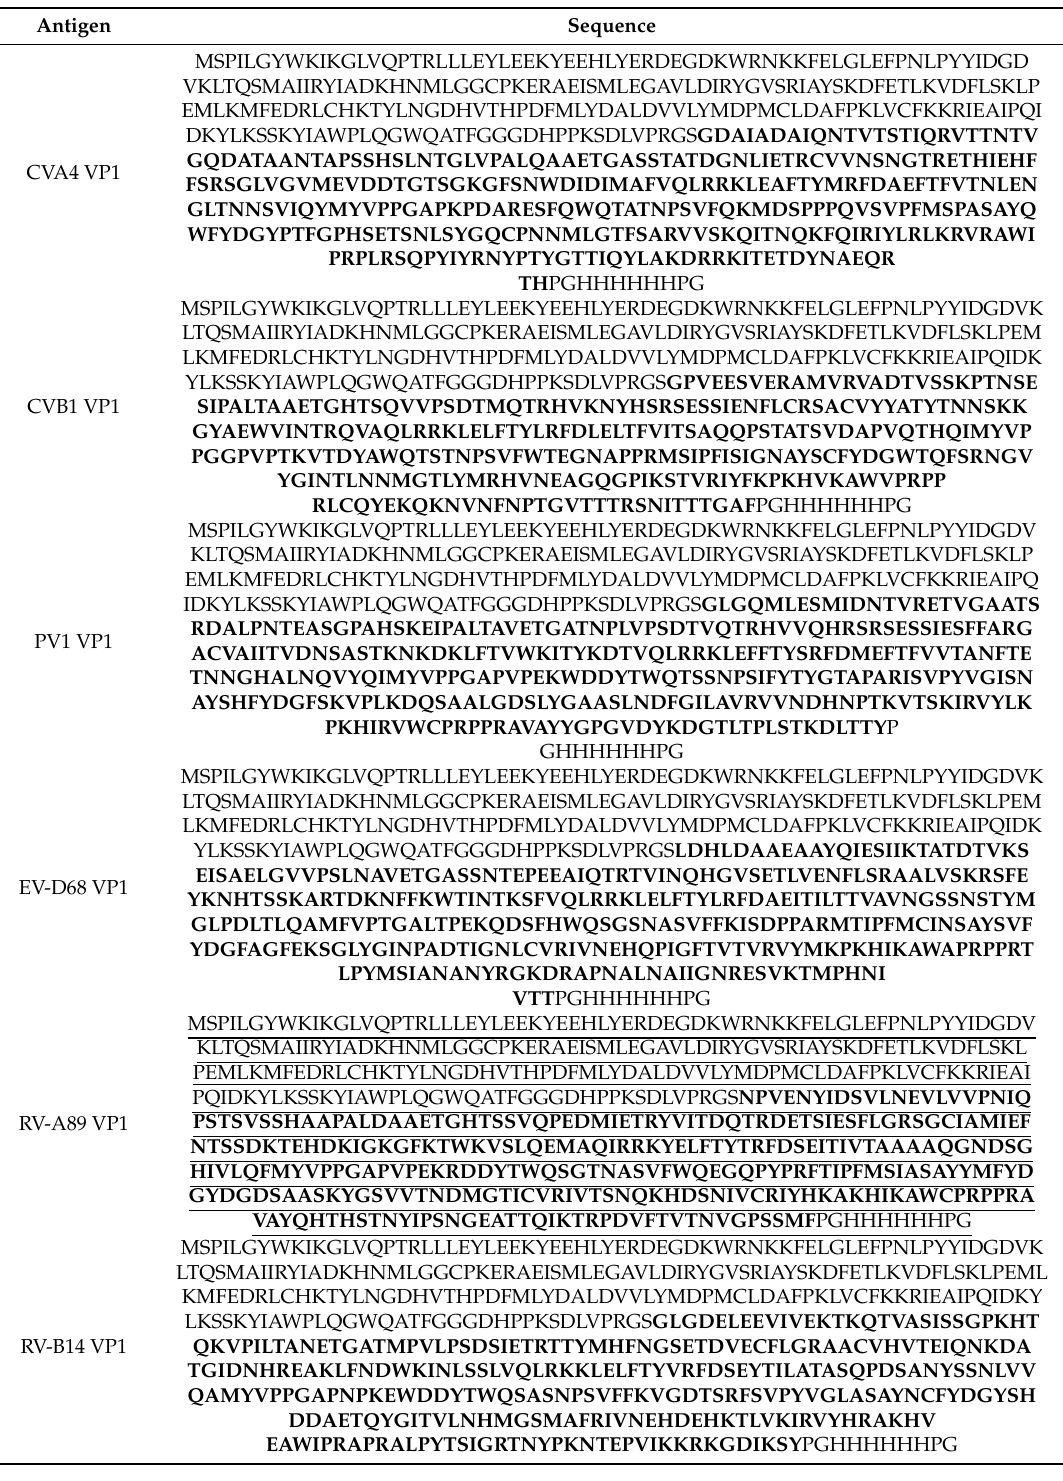
Table A2. Complete amino acid sequences of the recombinant VP1 antigens. VP1 parts unique to each antigen are typed in